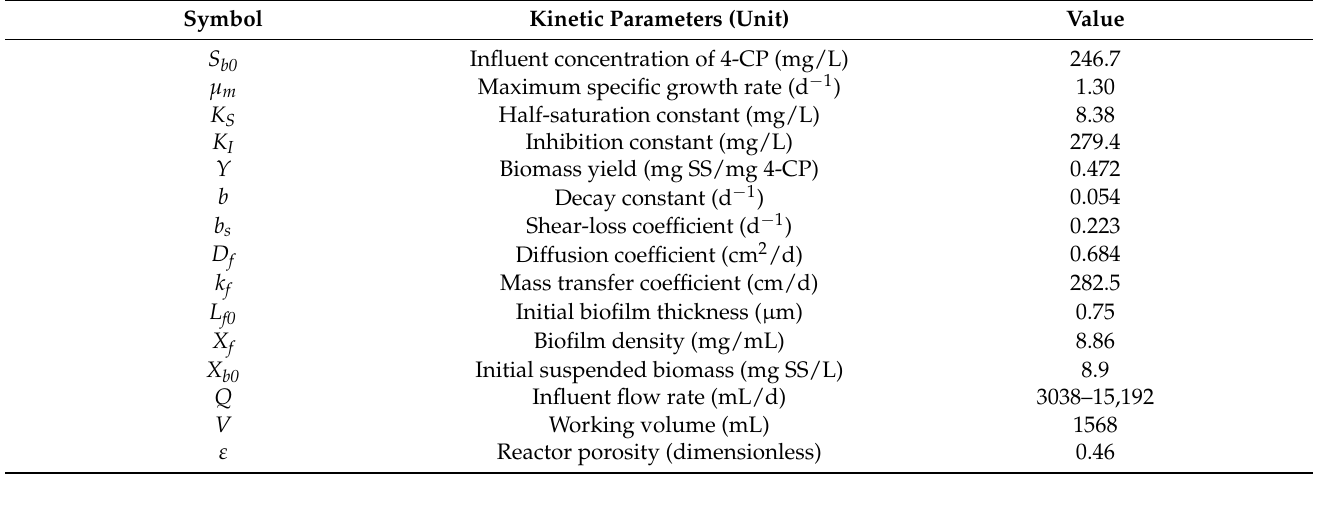
Table 1. Input parameters for kinetic model system of packed bed reactor.